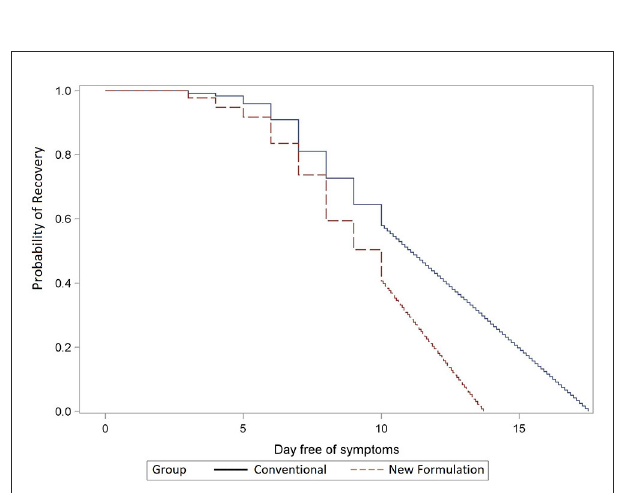
FIGURE3 Remission of all infection episodes extrapolated until full recovery. Comparison of recovery times of new (dashed line, A + B) vs. conventional (solid line, C + D) ( p < 0.001) formulations extrapolated beyond day 10 to absent symptoms; y-axis: